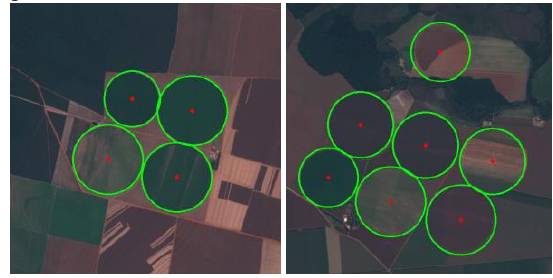
Figure 11. Examples of detections by